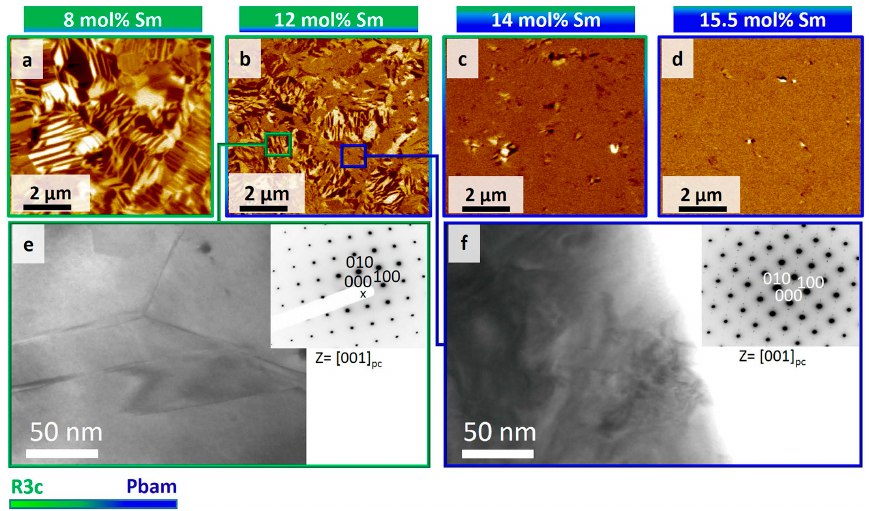
Figure 7. Dependence of the domain structure on Sm 2+ doping fraction. ( a – d ) PFM out-of-plane piezoresponse images obtained for 8 mol % Sm, 12 mol % Sm, 14 mol % Sm, and 15.5 mol % Sm, respectively; ( e , f ) Bright field (BF)-TEM images and associated selected area electron diffraction (SAED) patterns from 12 mol % Sm. ( e ) A region identified as R3c by corresponding SAED in [001] pc zone axis (inset), where regular domains are seen. ( f ) A region identified as Pbam phase by corresponding SAED (inset), where complicated nano-sized features are observed. The green-to-blue color transition approximately represents the change in wt % ratio of R3c and Pbam phases. PC denotes pseudocubic notation [92].